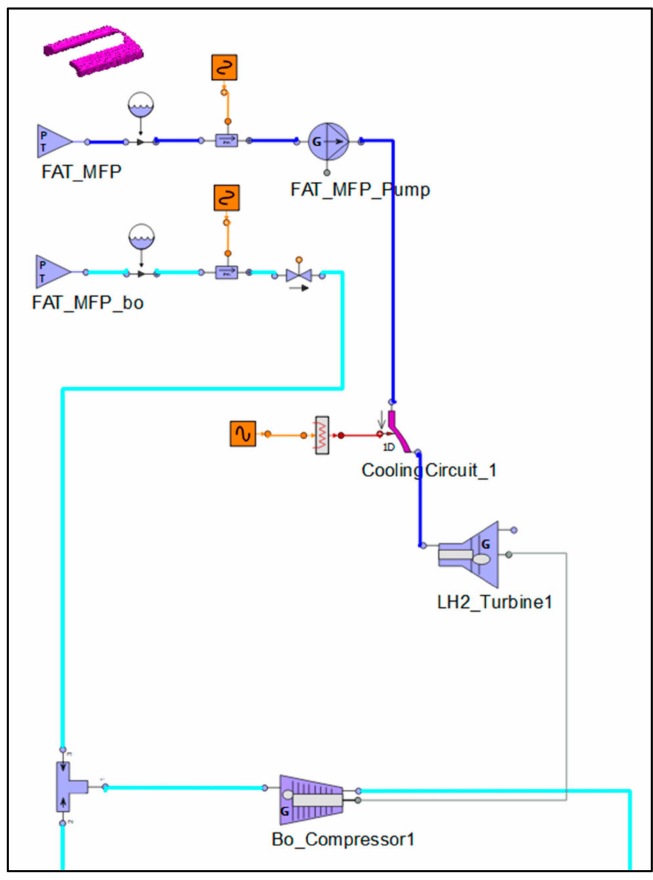
Figure 13. Front module, detail of primary tanks and